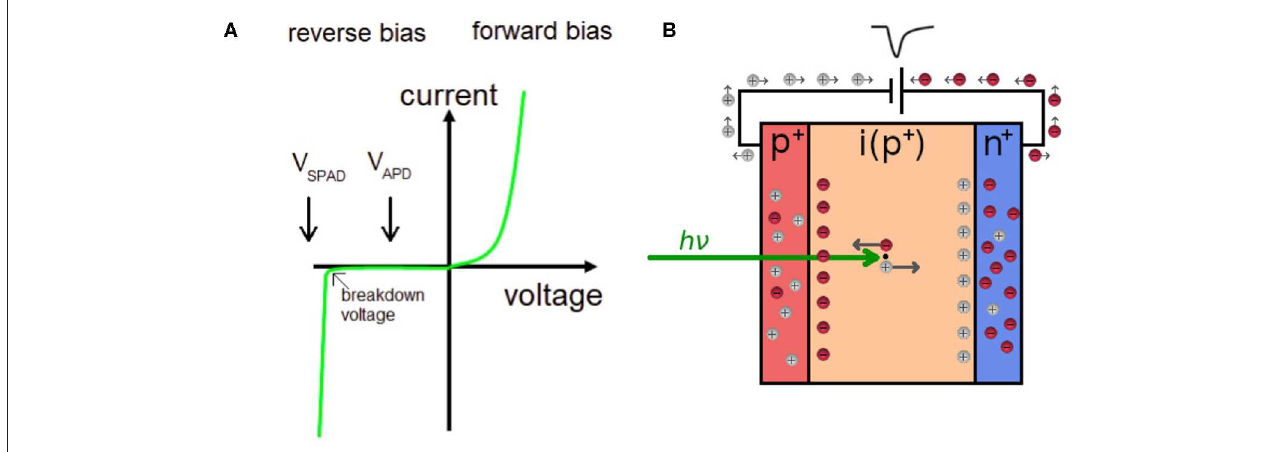
FIGURE 6 | (A) A schematic current-voltage characteristic for a diode. A SPAD is biased above the breakdown voltage of the diode, whereas an APD is biased below the breakdown voltage. (B) A schematic of a photodiode in reverse mode. A photon absorbed in the depletion region (i) creates an electron-hole pair, which through impact ionization produces a pulse for timing.